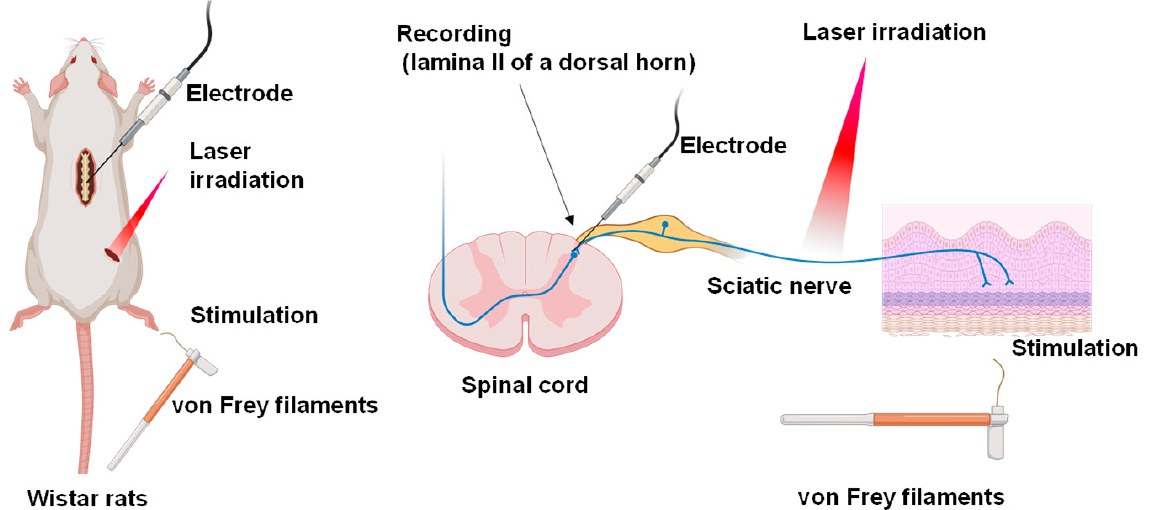
Figure 1. Schematic diagram of our experimental setup. Electrodes were inserted into lamina II of a rat spinal dorsal horn for recording. The skin of the right hind leg was incised to expose the sciatic nerve and irradiated with a laser. Mechanical stimulation with von Frey filaments (vFF) was applied to the cutaneous receptive field.